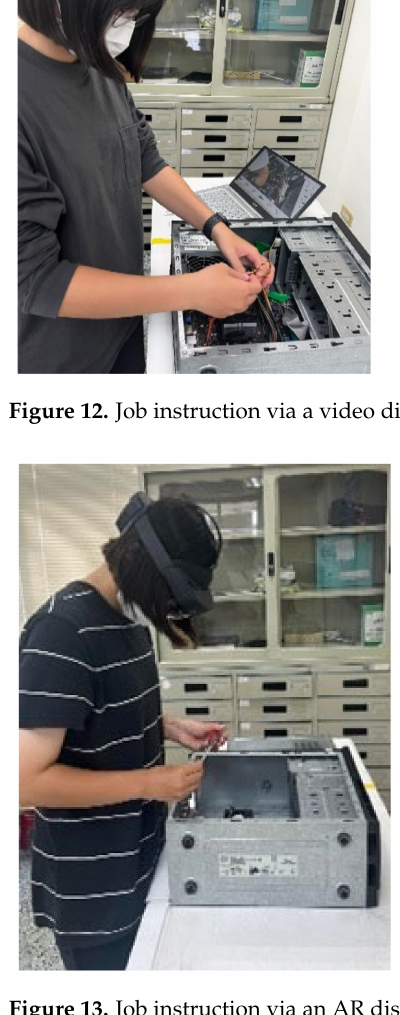
Figure 13. Job instruction via an AR